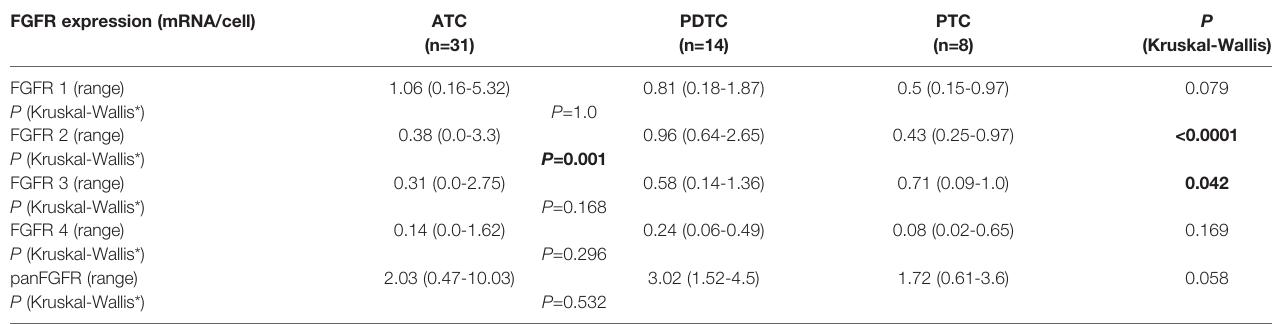
*p-values of Bonferroni testing for pairwise comparisons between ATC and PDTC are indicated.